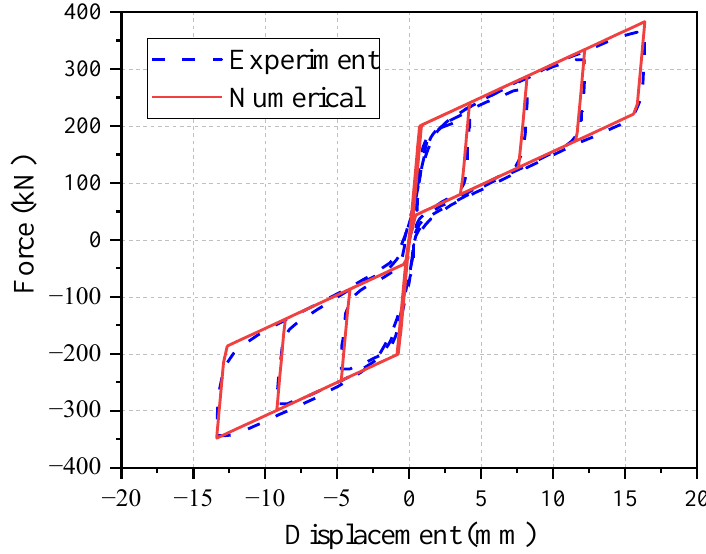
Figure 4. Numerical validation of PDSFD.